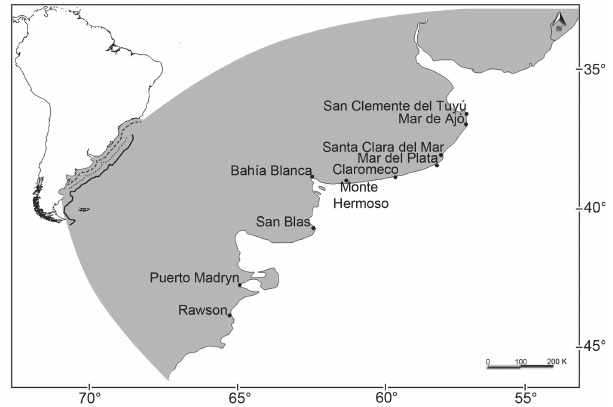
Fig. 1. Location of coastal localities and distribution range of study species in the south west Atlantic. Continuous line: Notorynchus cepedianus ; dotted line: Galeorhinus galeus ; dashed line: Carcharhinus brachyurus and Carcharias taurus